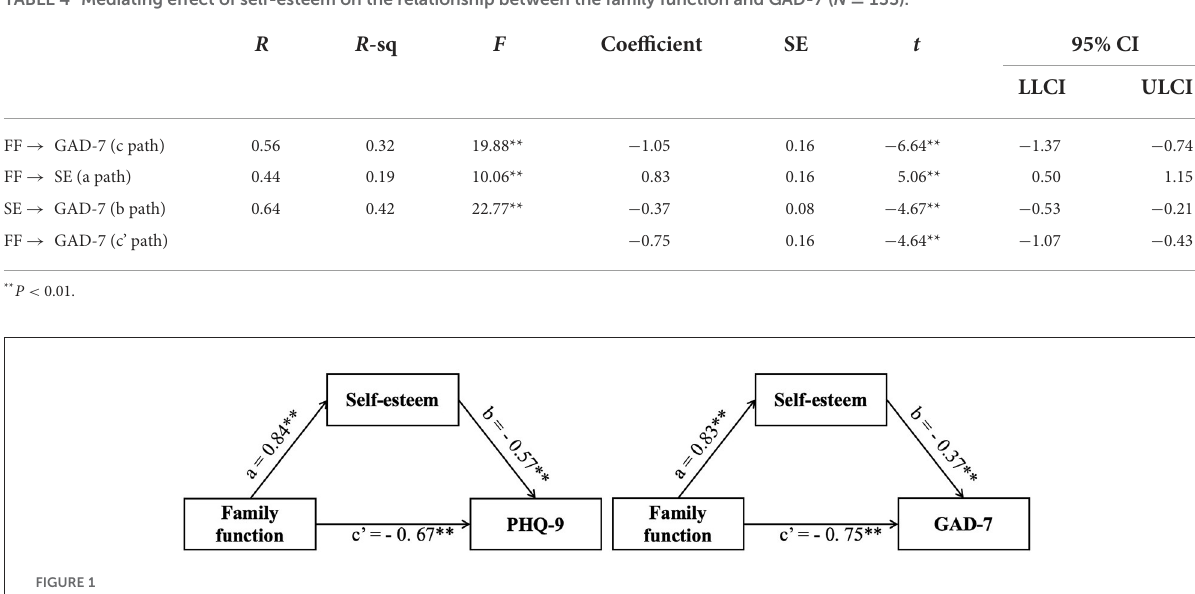
TABLE 4 Mediating effect of self-esteem on the relationship between the family function and GAD-7 ( N = 133).